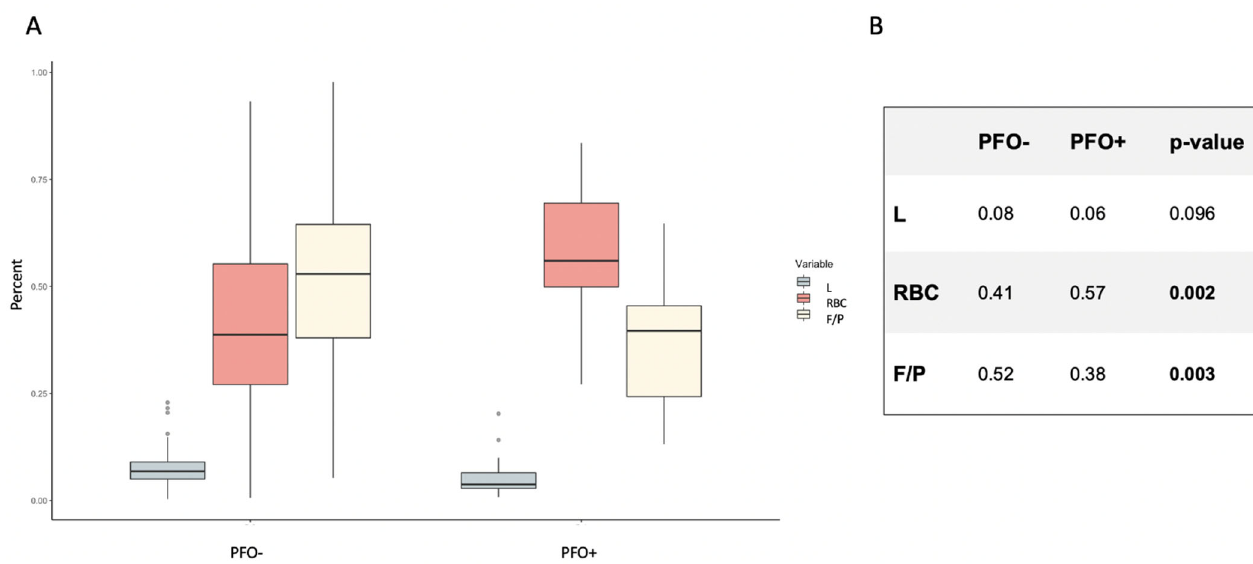
Figure 1. Histological clot composition in PFO– and PFO+ patients. Share of red blood cells (RBC) and fibrin/platelets (F/P) differed significantly in cryptogenic stroke depending on the presence (PFO+) or absence (PFO–) of a patent foramen ovale (PFO). ( A ) Boxplots of histological clot composition comparing PFO– and PFO+ subgroups. ( B ) Numerical overview comparing mean clot composition and the calculated p -value comparing PFO– and PFO+ groups. L = Leukocytes, RBC = red blood cell count, F/P = fibrin/platelets.